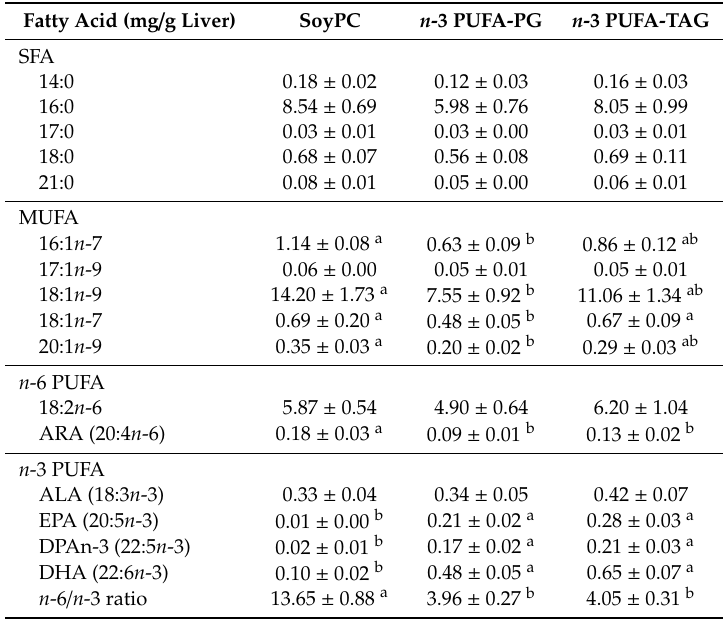
Table 7. Fatty acid composition of the neutral lipid in the liver of KK- A y mice fed experimental diets. Fatty Acid (mg / g Liver) SoyPC n -3 PUFA-PG n -3 PUFA-TAG